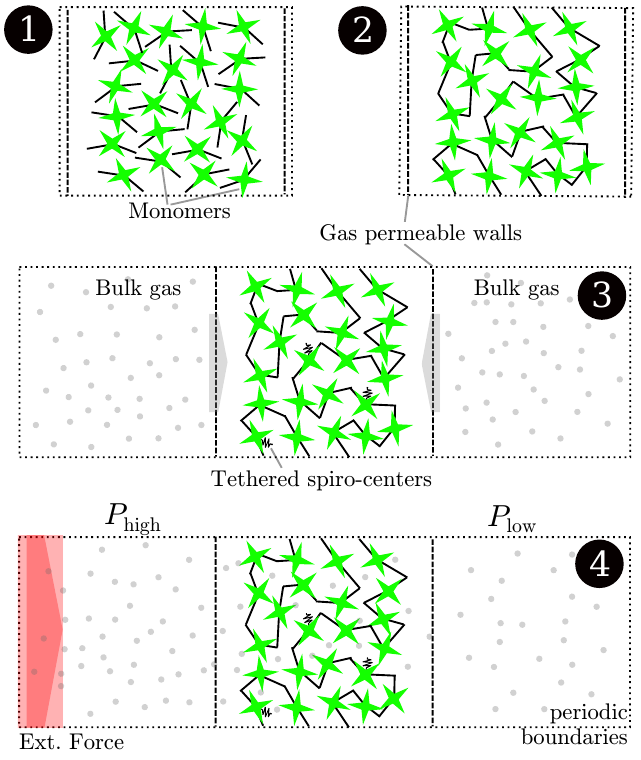
Figure 4. Schematic drawing of the simulation process. Initially, a simulation cell with two walls confining one specific dimension is populated with polybenzodioxane monomers (1). The sample is polymerized to create the PIM-1 2D sample (2). The box is elongated in the dimension of the two walls, which are made permeable for gases. While some selected carbon atoms on the polymer backbone are tethered to keep the structure from shifting inside the wall, the gases pass through the walls and adsorb to the polymer from the bulk regions during an equilibration run (3). Finally, an external field is imposed on the boundary, creating regions of higher and lower pressure on either side of the polymer. The steady-state flux and pressure difference are measured during this non-equilibrium molecular dynamics (NEMD) run